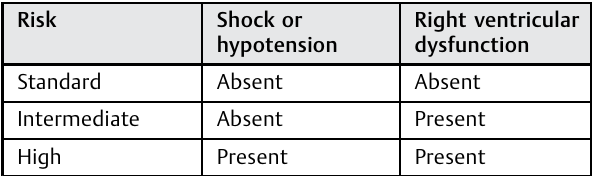
Table 1 Risk strati fi cation of acute pulmonary embolism 23